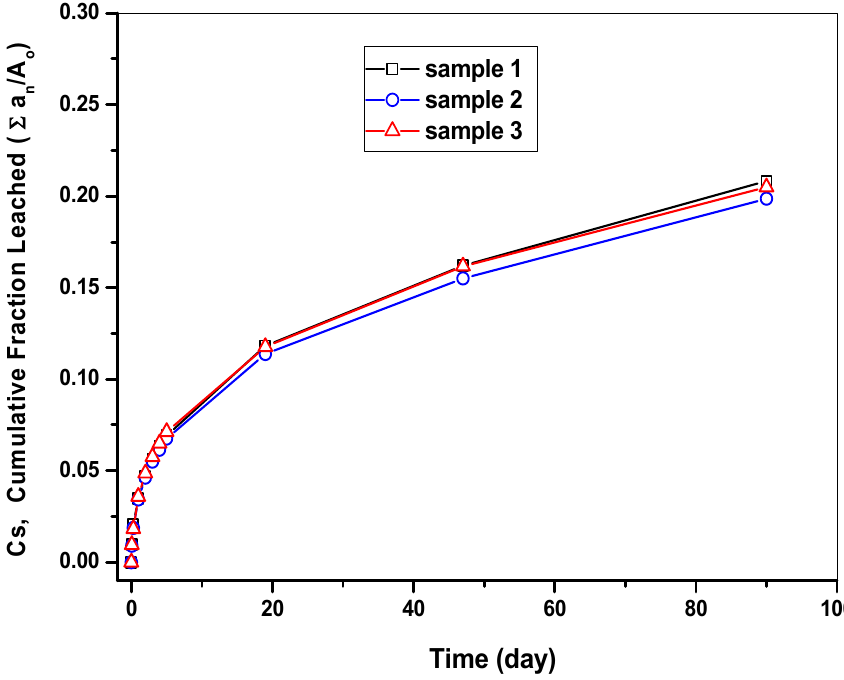
Figure 9. Cumulative fraction leached of Cs measured from the cement waste form.